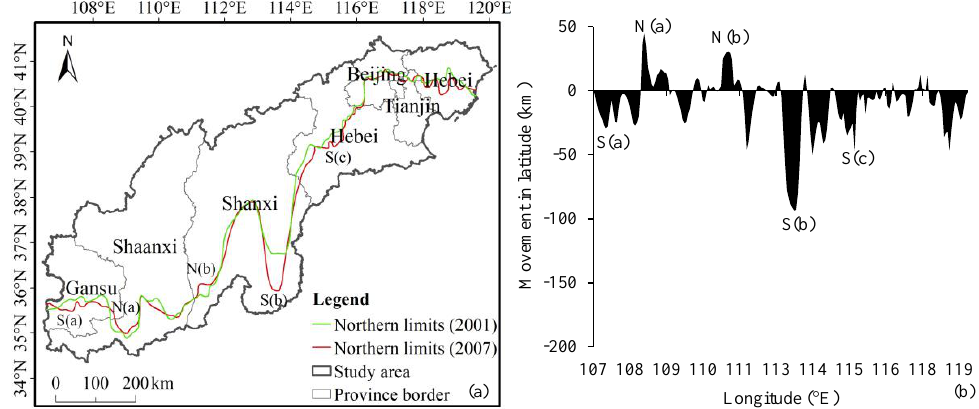
Figure 9. ( a ) Derived extent of the NLWW and ( b ) latitudinal movement of the NLWW during the period 2001–2007 (Red solid lines show NLWW at end of period, green solid lines show NLWW at beginning of period, black bars indicate latitudinal movement of NLWW, S(a, b, c) represent typical points of southward migration, and N(a, b) represent typical points of northward migration.). During the period 2007–2014, the average movement of the NLWW was 23 km southward. It moved 76 km to the south in the transition area between the Shaanxi Basin and Shaanxi Plateau (represented by S(a) in Figure 10a and 10b). The area where the NLWW moved more obviously southward was the Shanxi Central Plain (163 km; represented by S(b) in Figure 10a and 10b). The NLWW shifted 53 km southward on the border area of the Hebei Plain and Hebei mountain (represented by S(c) in Figure 10a and 10b). In addition, there was northward movement of 29 km on the Loess Plateau of eastern Gansu (represented by N(a) in Figure 10a and 10b).